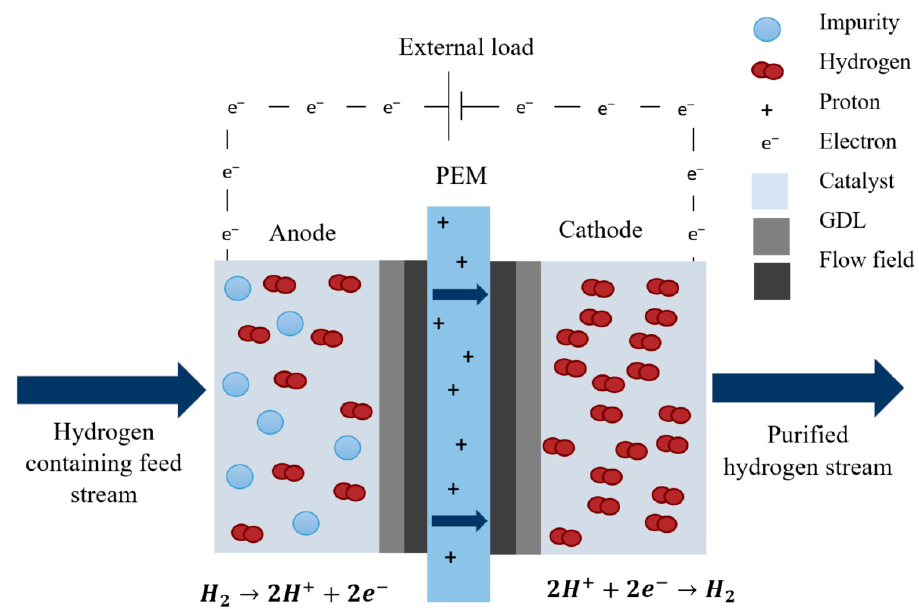
Figure 4. Schematic of the working principle of an ideal electrochemical hydrogen separator.